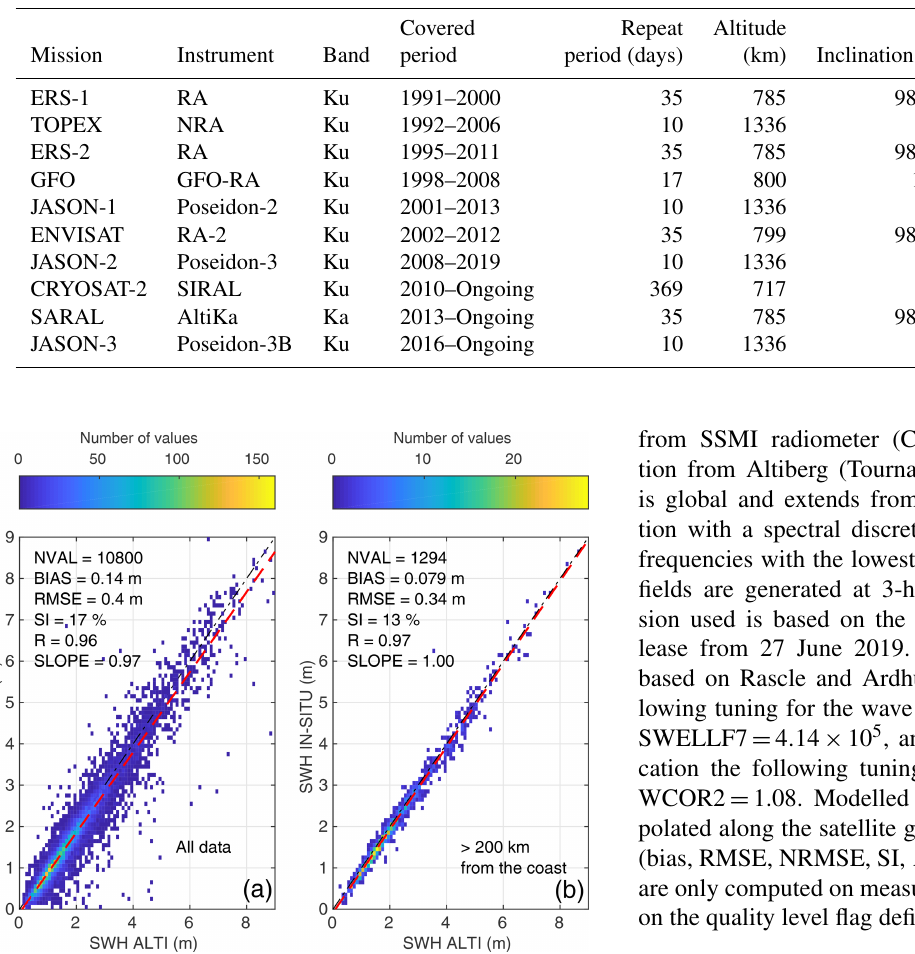
Figure 2. Comparison between SARAL and wave in situ SWH measurements during the year 2017, when all in situ sites are con- sidered (a) and when only locations 200km away from the coast are considered (b)